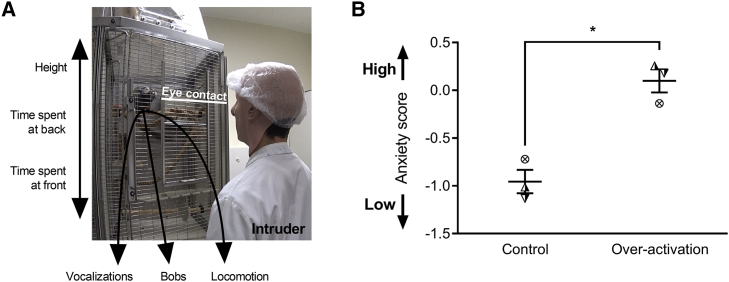
sgACC/25 Over-Activation Does Not Cause a General Blunting in Emotional ArousalRelevant graphs show mean ± SEM (n = 3).(A) In the human intruder test, marmosets are divided into a quadrant of their home cage and are confronted with a human intruder who maintains eye contact for 2 min. Marmosets display a range of behaviors in response to the intruder, including vocalizations (tsik, tse, tsik-egg, tse-egg, and egg calls), bobbing (rapid side-to-side movements), and locomotion (translational movements). These behaviors—together with average height, the time spent at the back of the cage, and the time spent at the front of the cage—are measured and loaded onto a single EFA-extracted factor representing anxiety (see Table S5 and STAR Methods).(B) Anxiety (factor) score following control infusions and over-activation of sgACC/25. Over-activation increased marmosets’ anxiety toward the human intruder reflected by an increased anxiety score (two-tailed paired t test, p = 0.047).